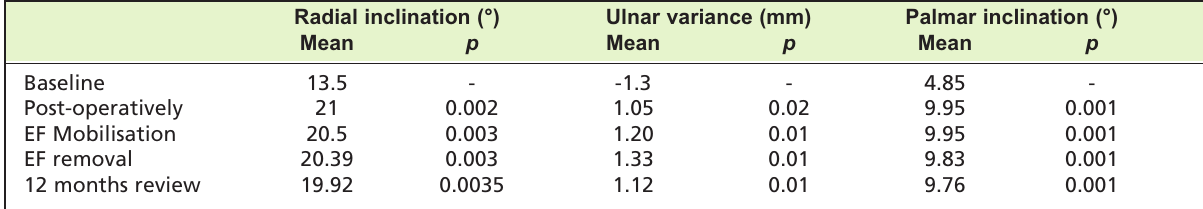
Radiological Analysis: differences at each follow-up review versus baseline (Paired Table III: